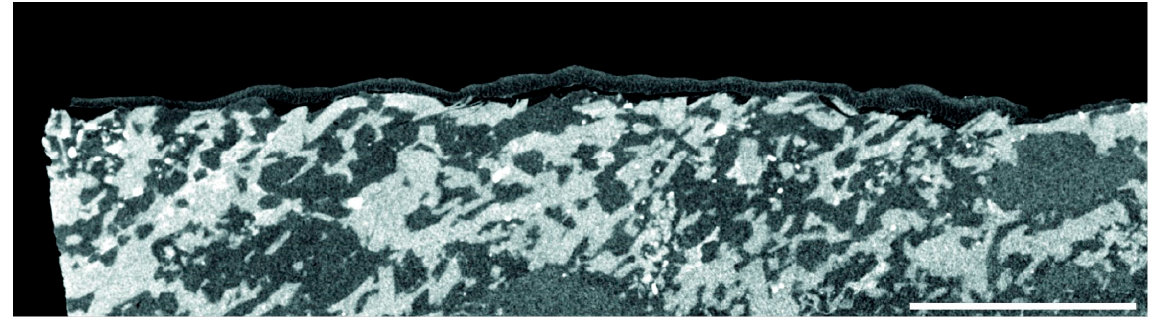
Figure 5. Reconstructed µCT image showing an attachment with an organic-rich and poorly calci- fied basal layer (dark), overlain by the strongly calcified main thallus (light) of T. antarcticum (crust thickness = ±100 µm) to its substrate. Scale bar = 1 mm.